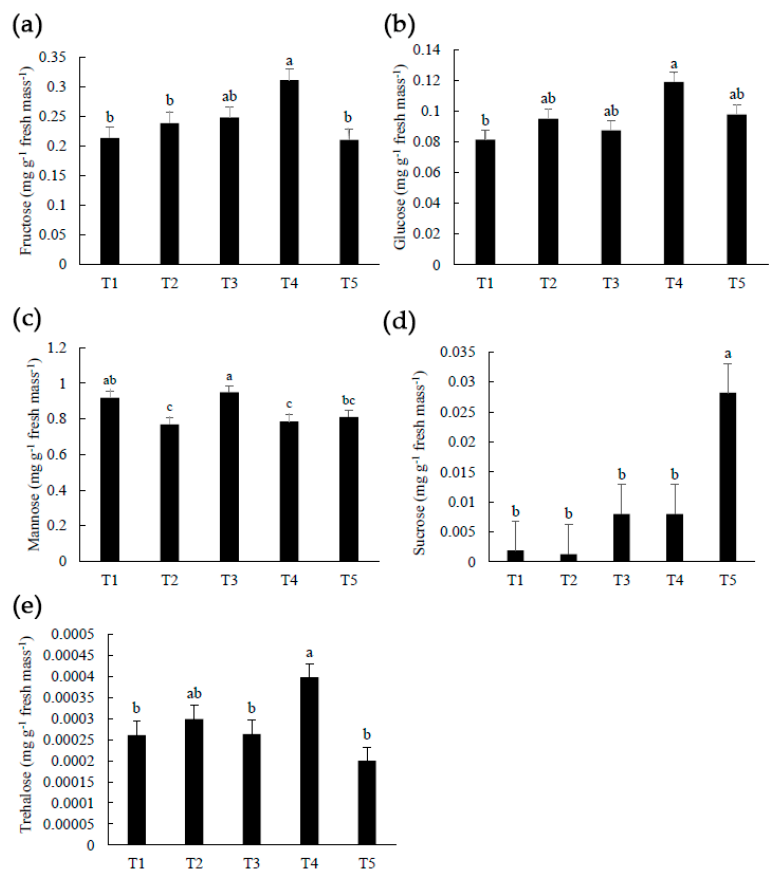
Figure 2. ( a ) Fructose, mg g − 1 fresh matter; ( b ) Glucose, mg g − 1 fresh matter; ( c ) Mannose, mg g − 1 fresh matter; ( d ) Sucrose, mg g − 1 fresh matter; ( e ) Trehalose, mg g − 1 fresh matter, in atemoya (